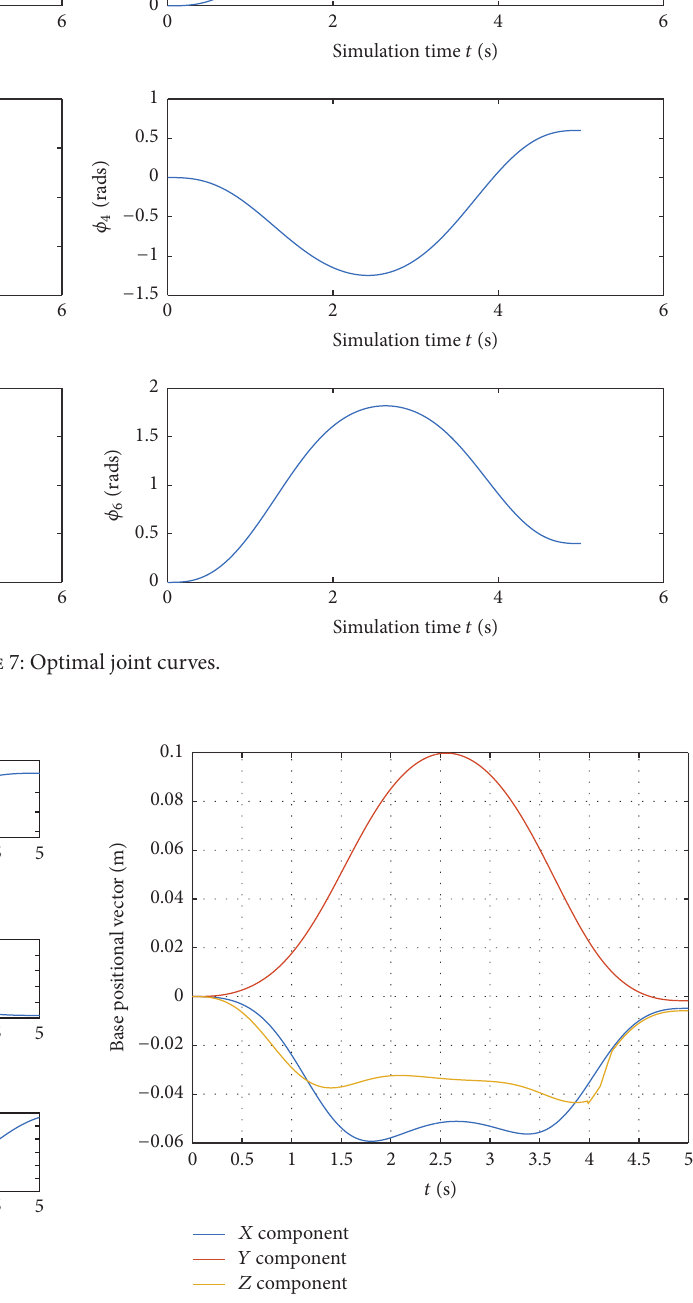
Figure 9: Positional curves of the floating base. Our method can efficiently reduce the energy consump- tion and time in a coordinated control process between a floating base and a